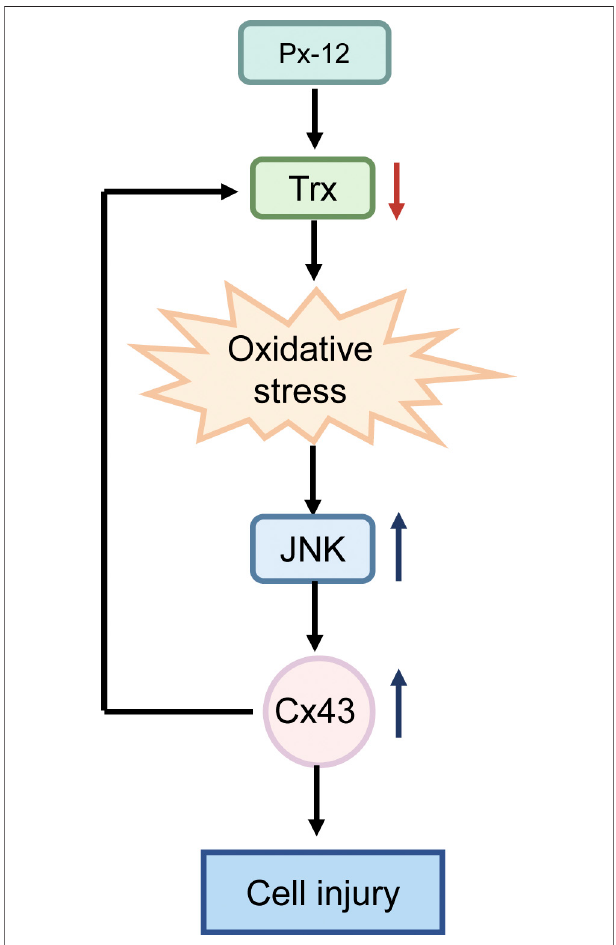
FIGURE 6 | Schematic depiction of reactive oxygens species (ROS)-c- Jun N-terminal kinase (JNK)-connexin 43 (Cx43)-thioredoxin 1 signaling mechanisms involved in renal tubular cell redox signaling. Inhibition of thioredoxin 1 by Px-12 induces oxidative stress, JNK activation, and subsequent Cx43 expression. Suppression of Cx43 improves levels of thioredoxin 1 and inhibits ROS-JNK. ROS-JNK-Cx43-thioredoxin 1 are reciprocally regulated and participate in renal tubular oxidative